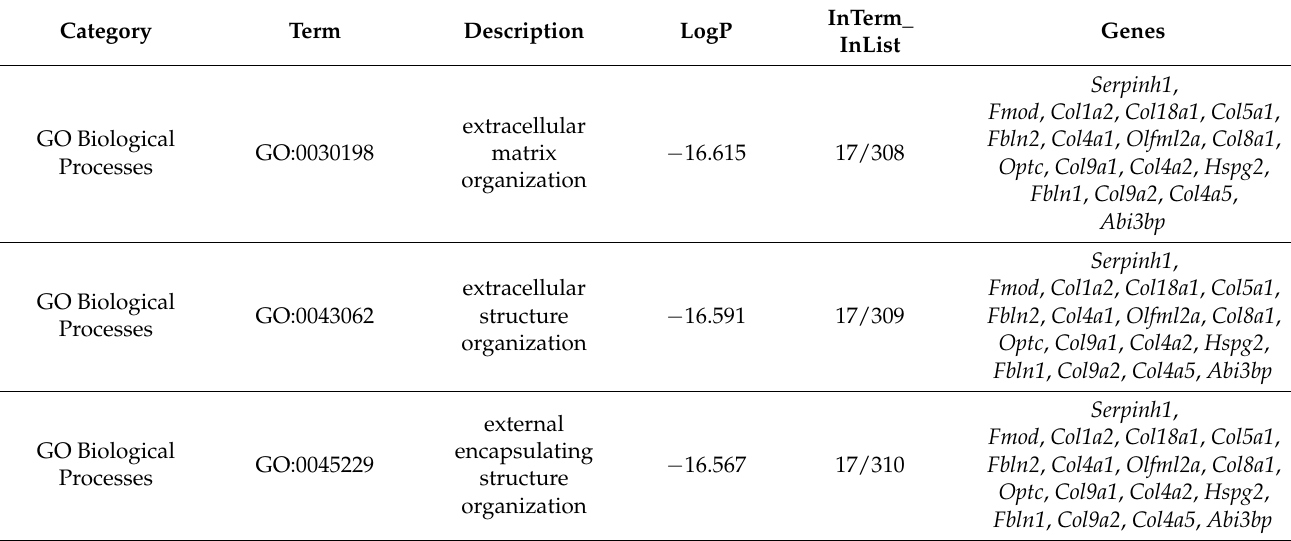
Top enriched GO terms significantly enriched in DEGs related to anti-apoptosis in NK-5962-treated retinas (Metascape).